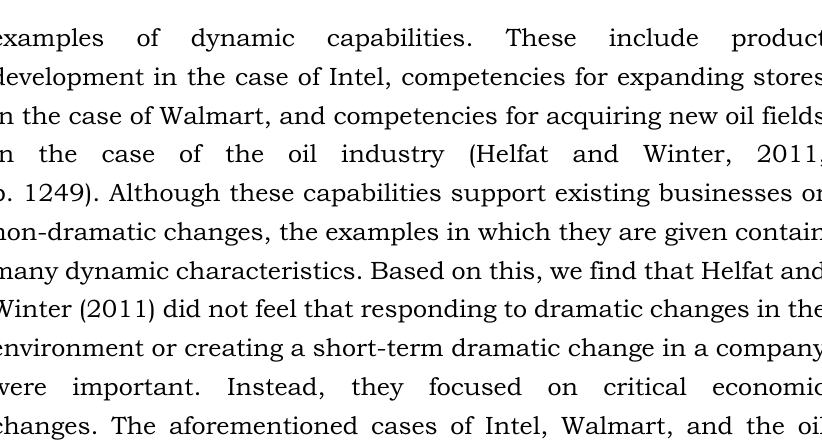
Figure 1. Relation between